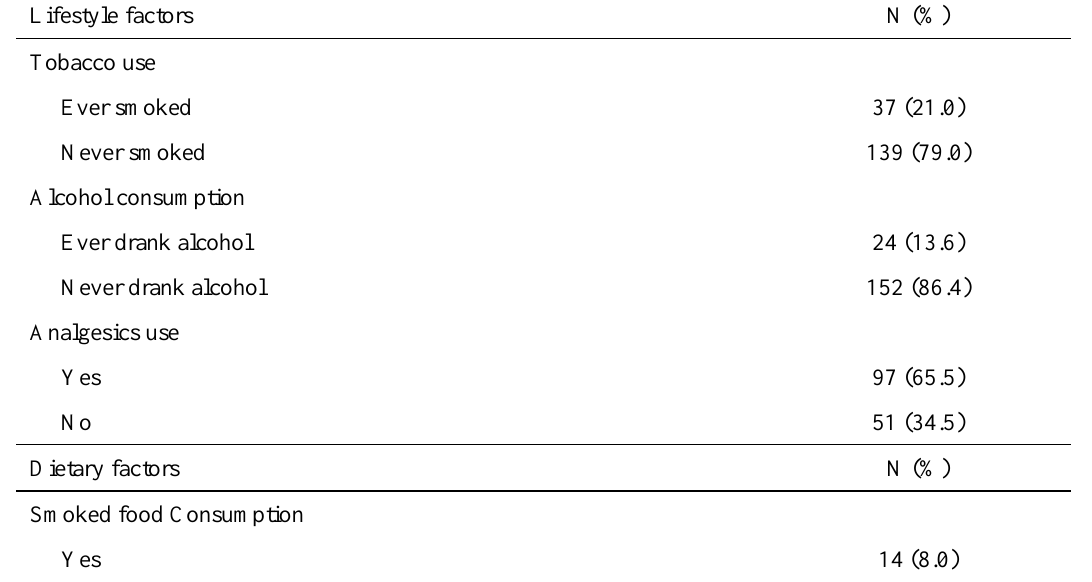
Table 2: Distribution of participants based on lifestyle and dietary factors Lifestyle factors N (%) Tobacco